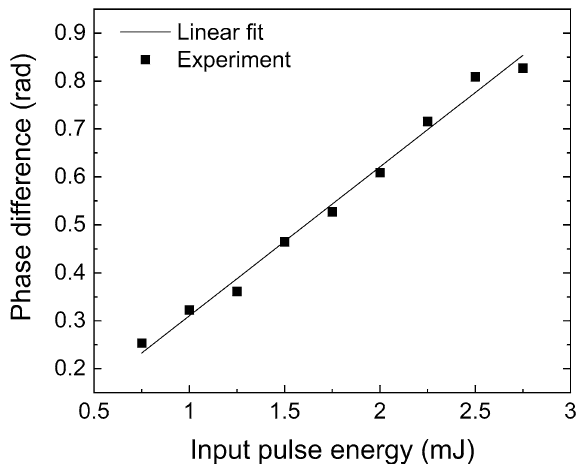
Figure 4. Intensity dependent nonlinearity induced dual-wavelength relative phase evolution. Additional relative phase shift θ f calculated from Eq. (8) (square) and linear fitting δI ω from Eq. (9) (solid line) as a function of the incident pulse energy.